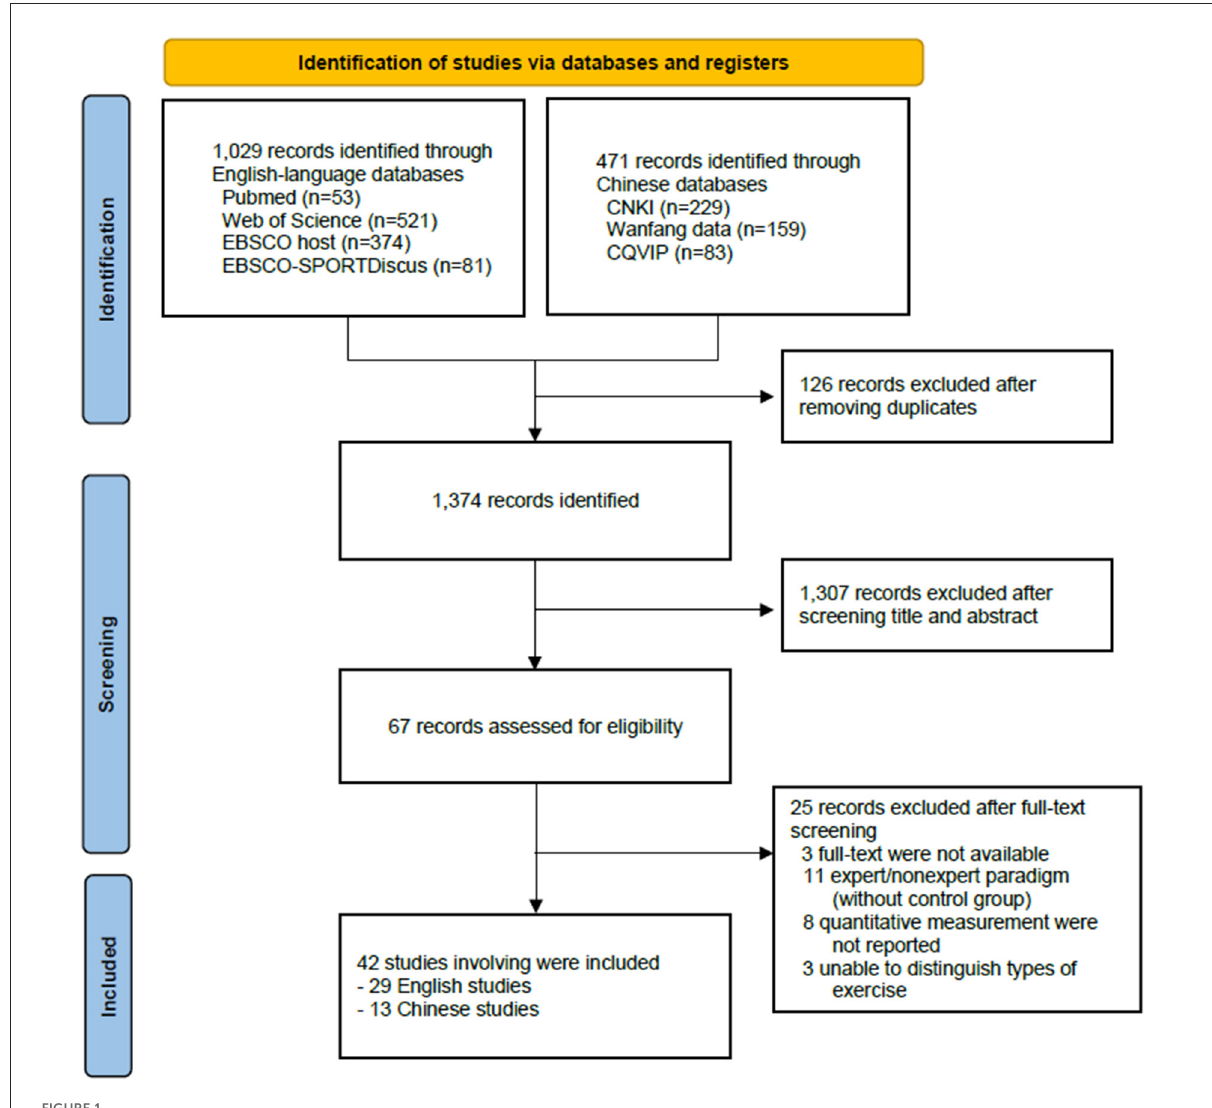
FIGURE1 Flowchart of the selection of eligible